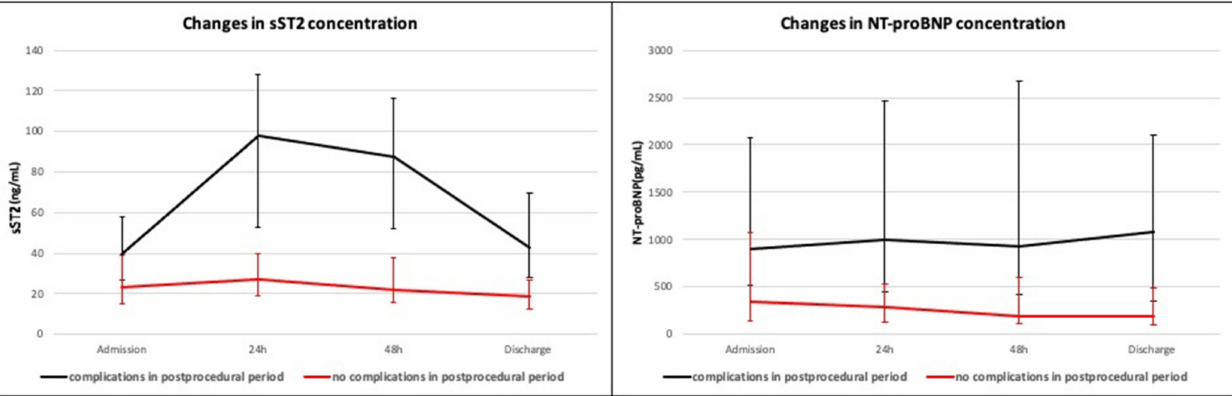
Figure 1. Changes in sST2 and NT-proBNP concentration in the groups with and without complications in the postprocedu- ral period.